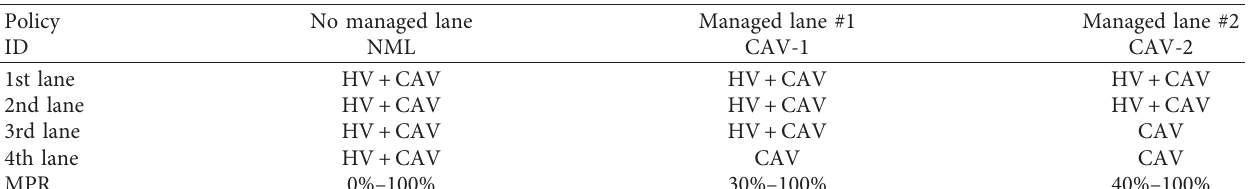
Figure 1: Network geometry and demand. Table 4: Managed lane evaluation plan.